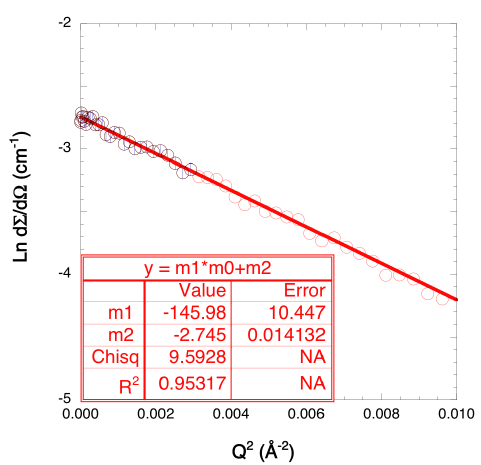
Figure 3. Guinier approximation of the simulated SCS by using the SDF with σ = 0.2. The points used for the Guinier approximation are shown with black symbols, while the others are red. The fit is shown with a red line.